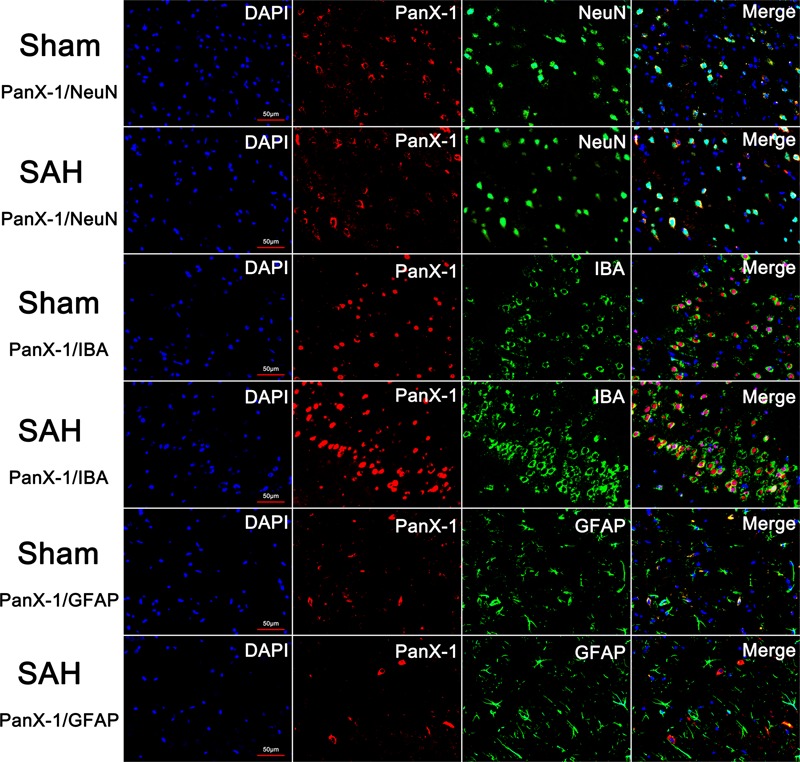
The expression and distribution of Pannexin-1 Channels were detected by double immunofluorescent staining. Pannexin-1 Channels/NeuN, Pannexin-1 Channels/IBA and Pannexin-1 Channels/GFAP co-staining in the Sham group and SAH group (Pannexin-1 Channel = red, NeuN, IBA and GFAP = green, DAPI = blue). According to the result of immunofluorescence staining, at the cellular level, Pannexin-1 Channels were expressed mainly in neurons and microglial cells, whereas infrequently expressed in astrocytes. Data not shown.